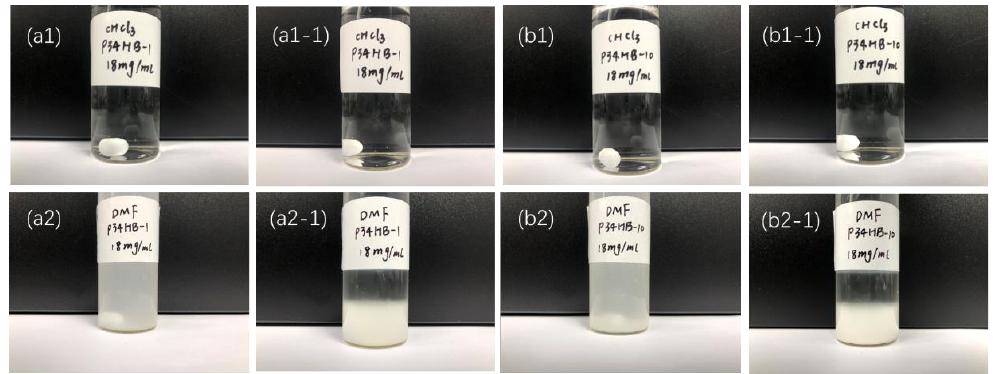
Figure 2. Solubility of P34HB-1 and P34HB-10 in CHCl 3 and DMF. ( a1 , b1 , a2 , b2 ) The state of the P34HB solution just after preparation. ( a1-1 , b1-1 , a2-1 , b2-1 ) The state in which the P34HB solution was prepared and placed for 48 h.